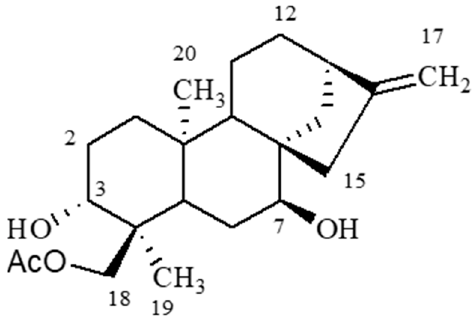
Figure 1. Structure of linearol. AcO: acetoxy group.